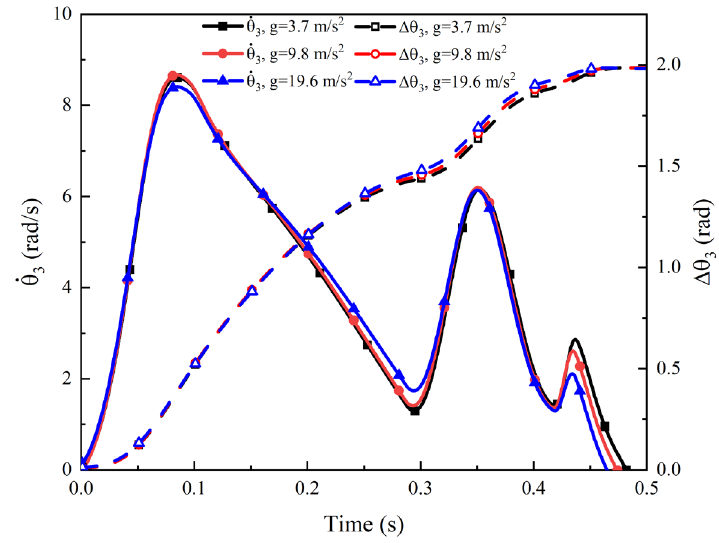
Figure 13. Comparison between different acceleration environments.